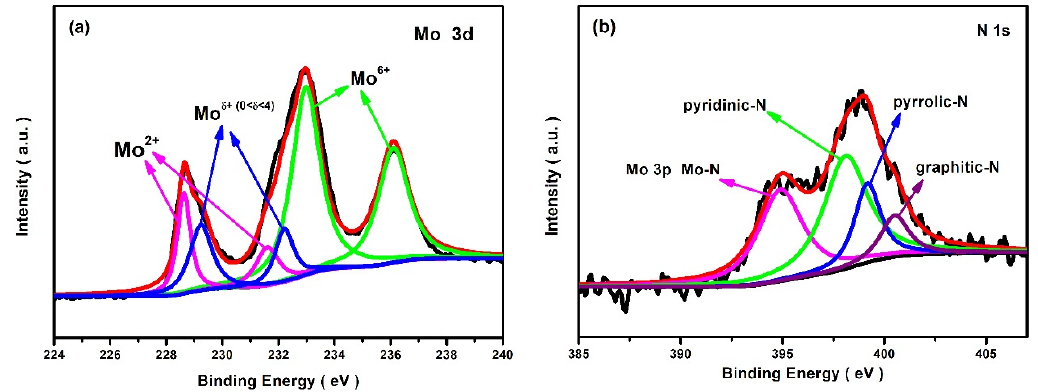
Figure 3. XPS spectra of the 250-800-2h catalyst, ( a ) Mo 3d and ( b ) N1s.